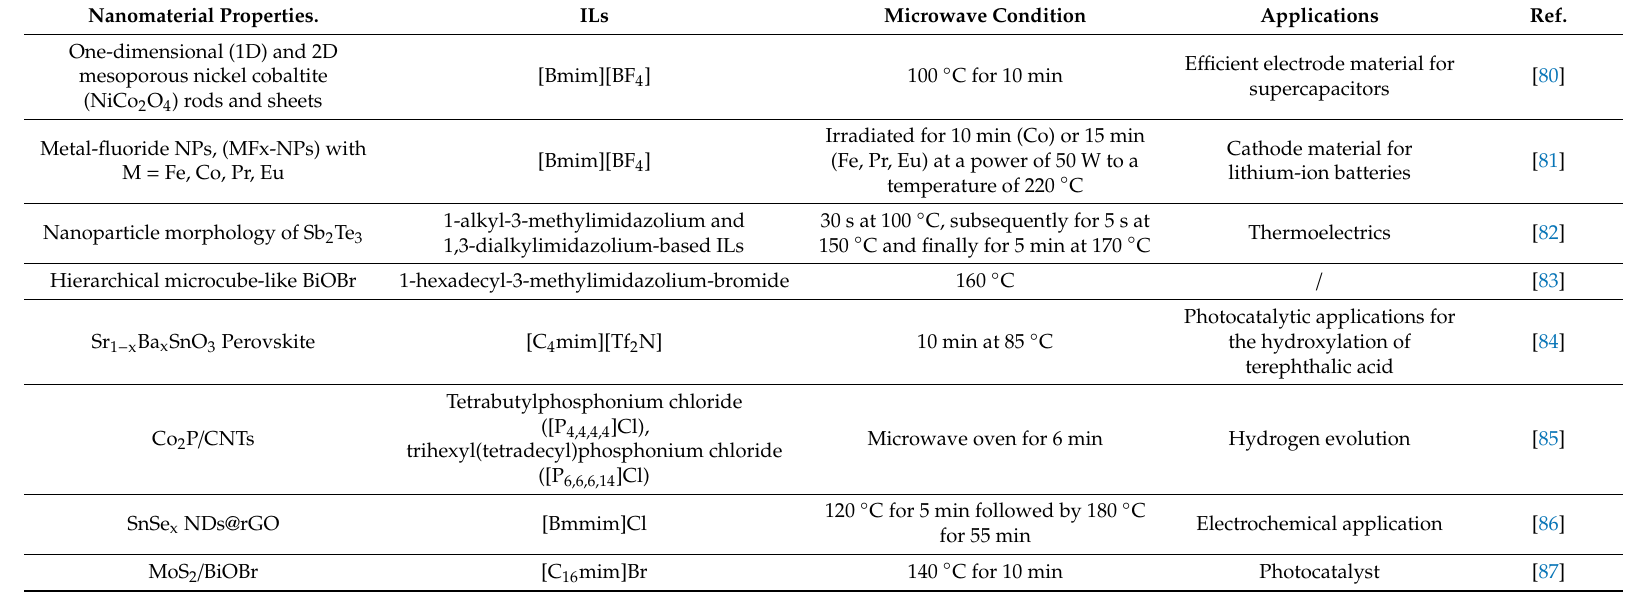
Table 1. An updated review of other metal structures prepared by microwave-assisted ionic-liquid (MAIL) methods reported in the literature. Nanomaterial